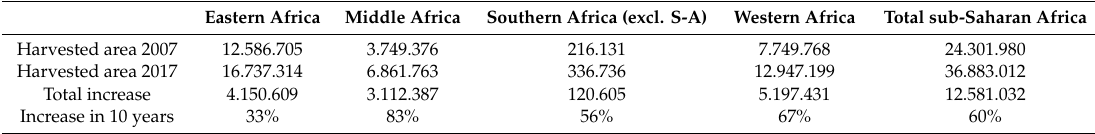
Table 1. Maize harvested area 2007–2017 in hectares.